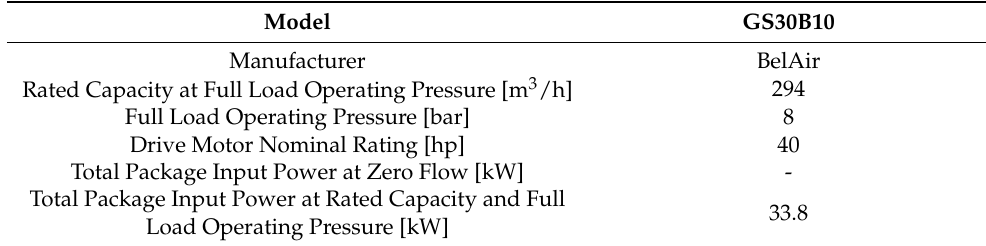
Table 1. Example of a manufacturer performance table of a fixed-speed air compressor. Based on BelAir datasheet